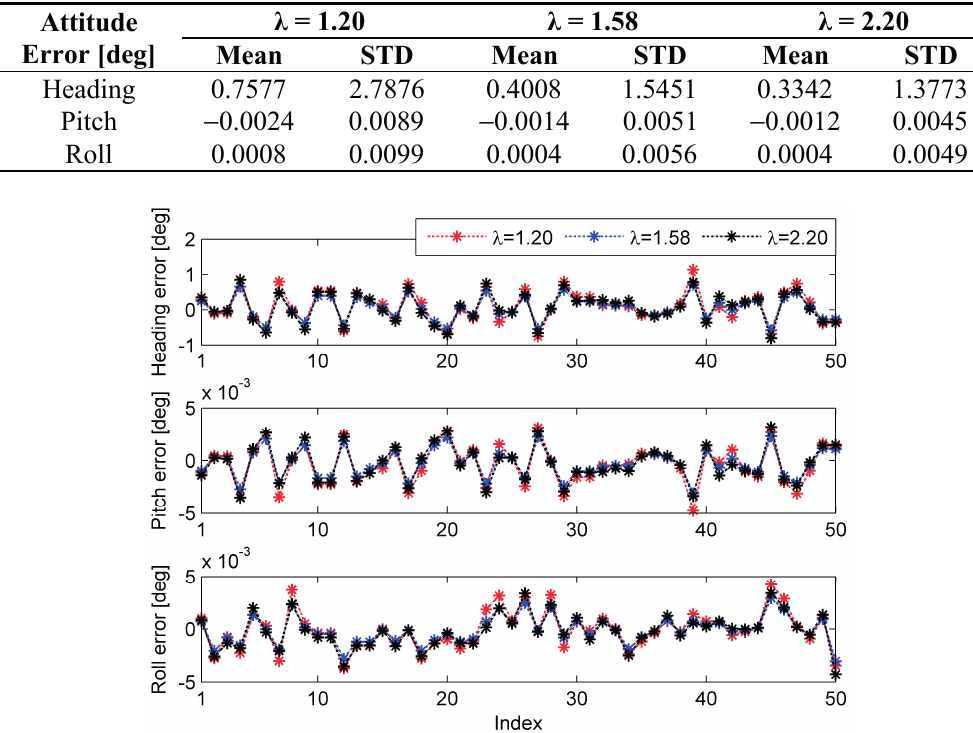
Figure 5. Attitude errors of the 50 simulations for Algorithm